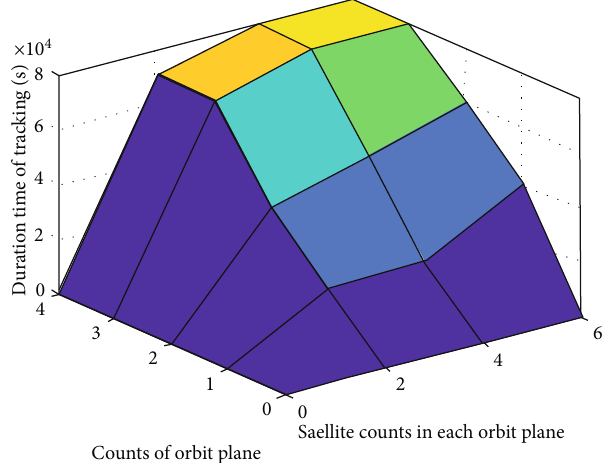
Figure 15: Simulation result of continuous tracking capabilities of swarms of di ff erent scales.